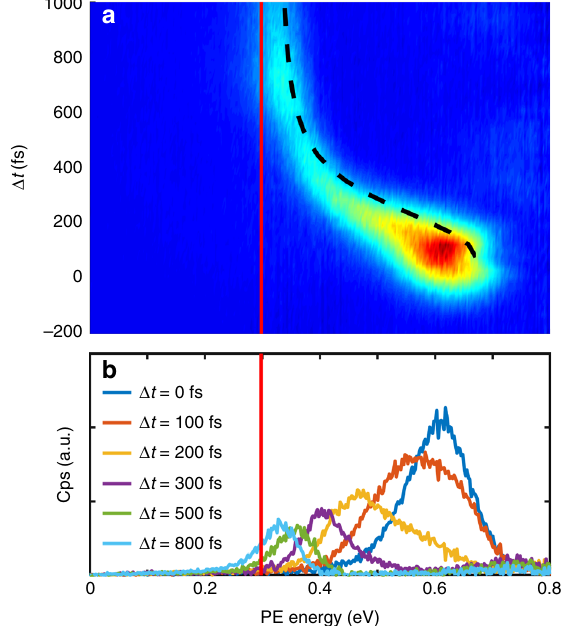
Fig. 2 Time-resolved photoelectron (PE) spectra of single In atoms solvated inside He N . The average droplet size is 4000 He atoms. a PE kinetic energy spectrum as the function of the pump – probe time delay Δ t , together with the simulated dynamics (dashed line) and the gas-phase PE energy (solid line). Around time-zero the PE signal is increased due to temporal overlap of the pump and probe pulses. Additionally, the total PE signal decreases during the expansion, which might be due to a decreased ionization probability for larger bubbles and/or lower escape probability of slow electrons from larger bubbles at long delays compared to fast electrons from small bubbles at short delays 17, 31 . b Selected spectra for different pump – probe time delays, which resemble horizontal cuts through the 2D plot in a